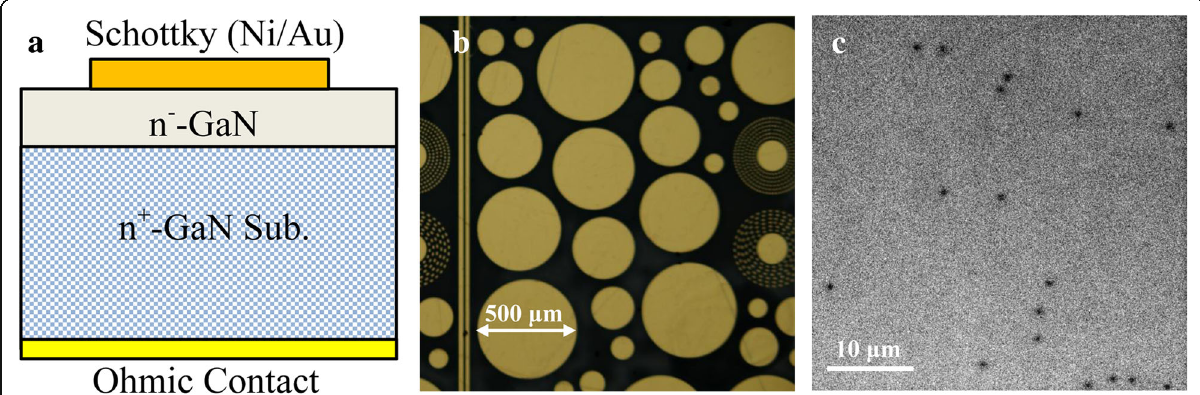
Fig. 1 a Schematic cross section of the fabricated vertical SBD. b Optical microscopy image of the different electrodes. c Panchromatic CL image of the epitaxial